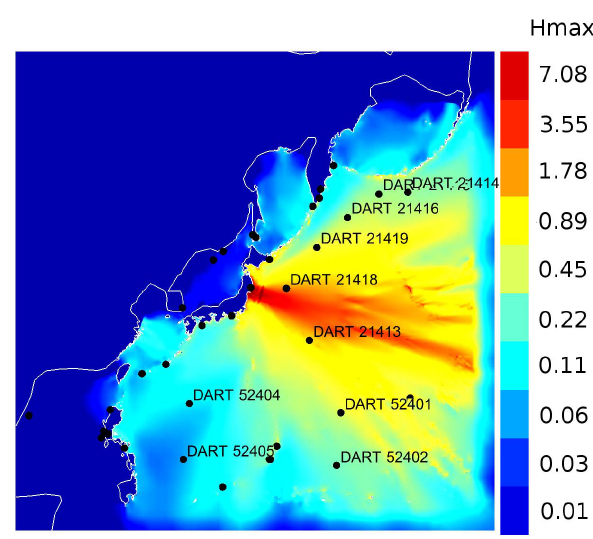
Fig. 9. Maximum wave elevation reached over 10h. The (logarith- mic) colorbar gives the maximum wave elevation in metres. The low values close to the boundaries of the domain are due to the mesh coarsening used to limit spurious wave reflections.